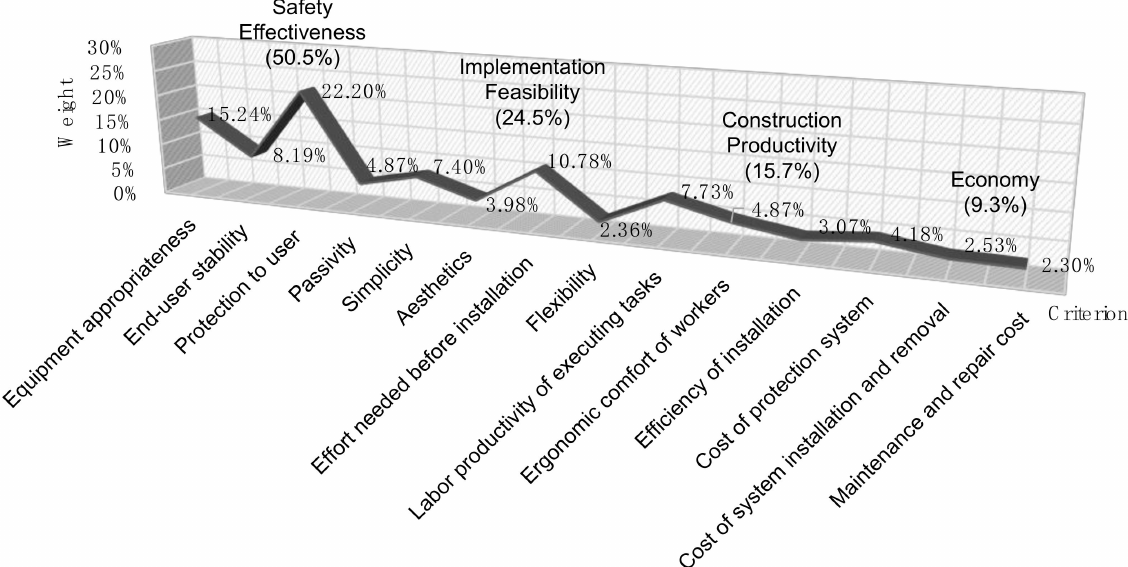
Figure 5. Normalized weight values of main criteria and sub-criteria in the fall protection alternative decision-making